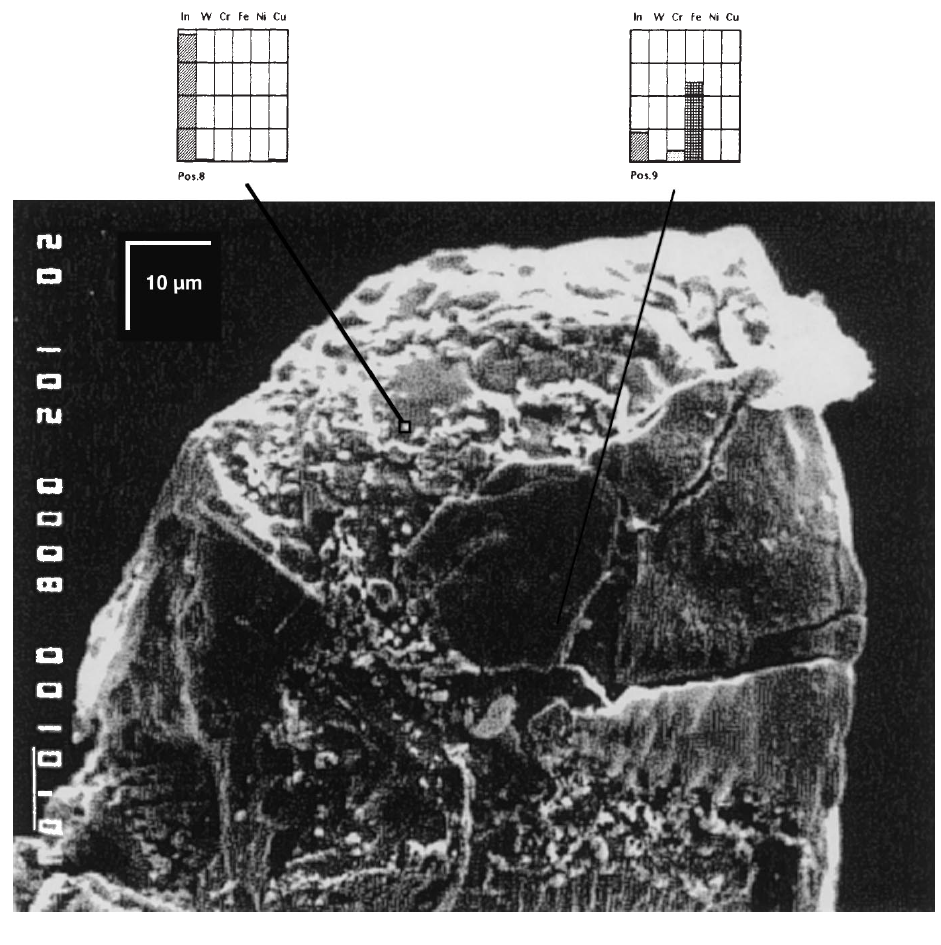
Fig. 3. Image of an indium emitter tip from an electron mi- croscope. At two selected areas elementary analysis has been performed. Relative particle numbers of elements are given in the bar graphs at the